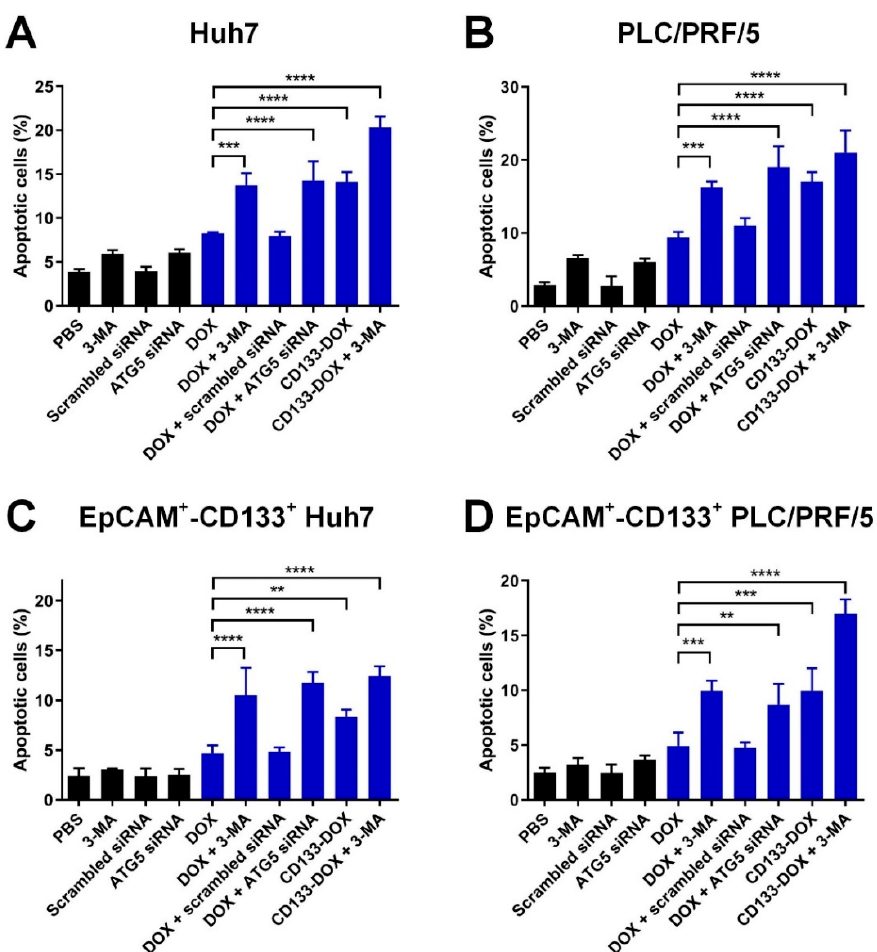
Figure 4. The effect of the inhibition of autophagy combined with the treatment of CD133 aptamer-DOX conjugates on DOX-induced apoptosis. The cells were treated with autophagy inhibitor 3-MA (2 mM) or ATG5 siRNA (200 nM) followed by the addition of either free DOX or an equivalent dose of CD133 aptamer-DOX conjugates (200 nM for Huh7 and 100 nM for PLC/PRF/5) for 24 h. The total percentage of apoptotic cells was defined by the combination of the percentage of 7-AAD - /Annexin V + and 7-AAD + /Annexin V + cells and are shown for the ( A ) bulk Huh7 cells, ( B ) bulk PLC/PFR/5 cells, ( C ) EpCAM + -CD133 + Hun7 cells, as well as ( D ) EpCAM + -CD133 + PLC/PRF/5 cells. Data shown are means ± SD, n = 3. ** p < 0.01; *** p < 0.001; **** p < 0.0001; compared with that in the DOX-only treatment.